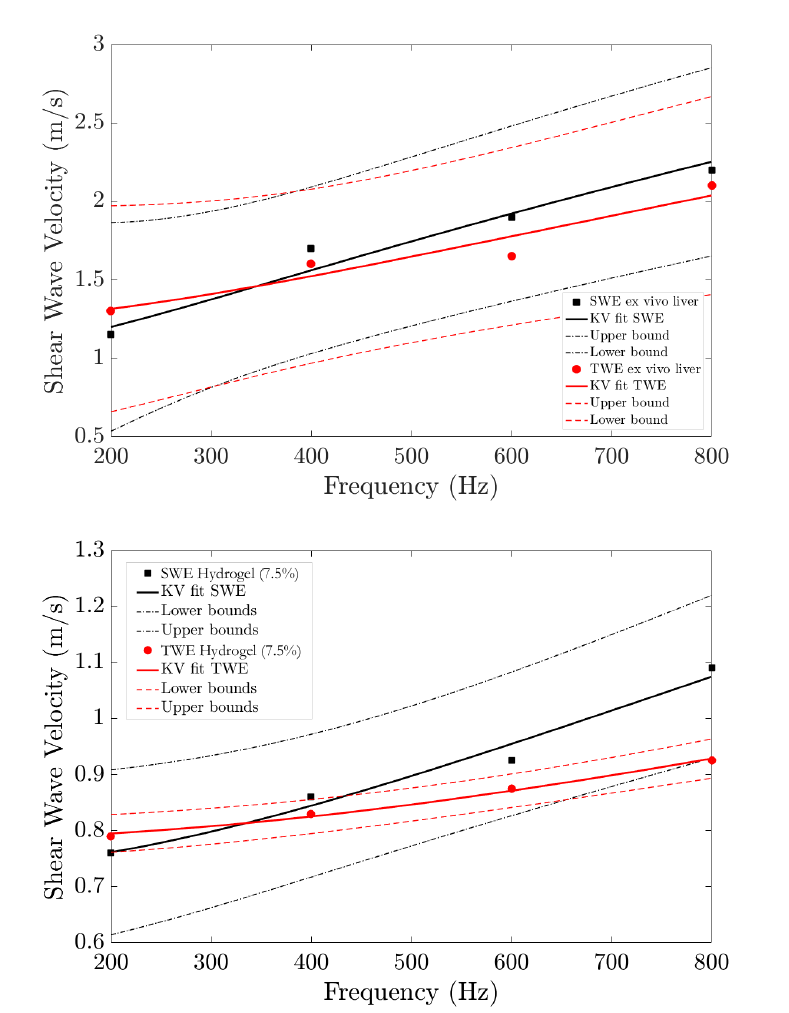
Figure 7. Dispersion curve for the two types of samples measured, square/circle marks are the values of shear wave velocity versus frequency via shear wave elastography imaging (SWEI) and torsional wave elastography (TWE) for ex vivo chicken liver samples ( top ) and hydrogel phantoms ( bottom ). Kelvin–Voigt (KV) fit is shown with solid lines in black color for SWEI and in red for TWE, and 95% confidence intervals are displayed with dashed